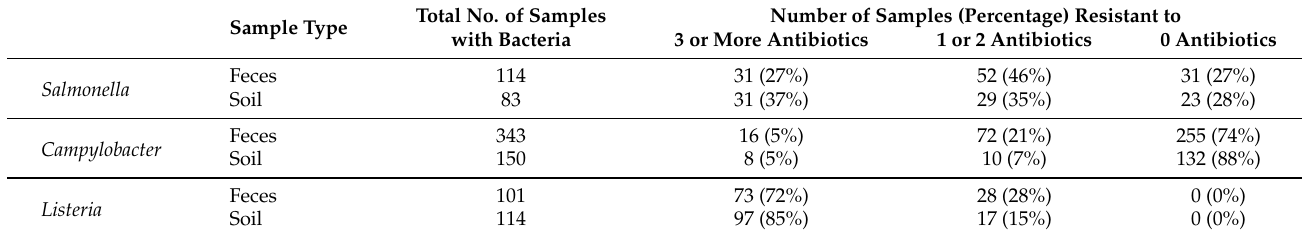
Table 1. Antibiotic resistance profile of Salmonella , Campylobacter , and Listeria in soil and feces. Sample